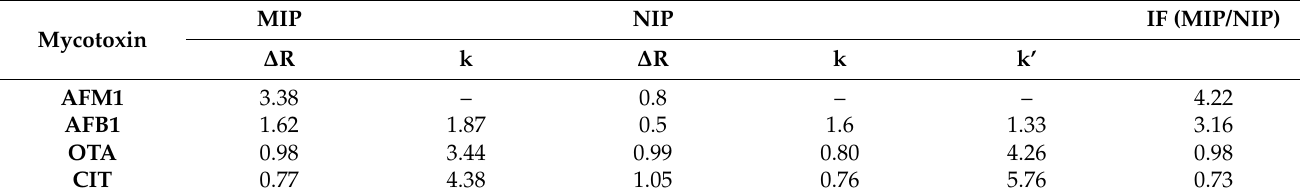
Table 3. The selectivity coefficient (k), relative selectivity coefficient (k’), and imprinting factor (IF) results.